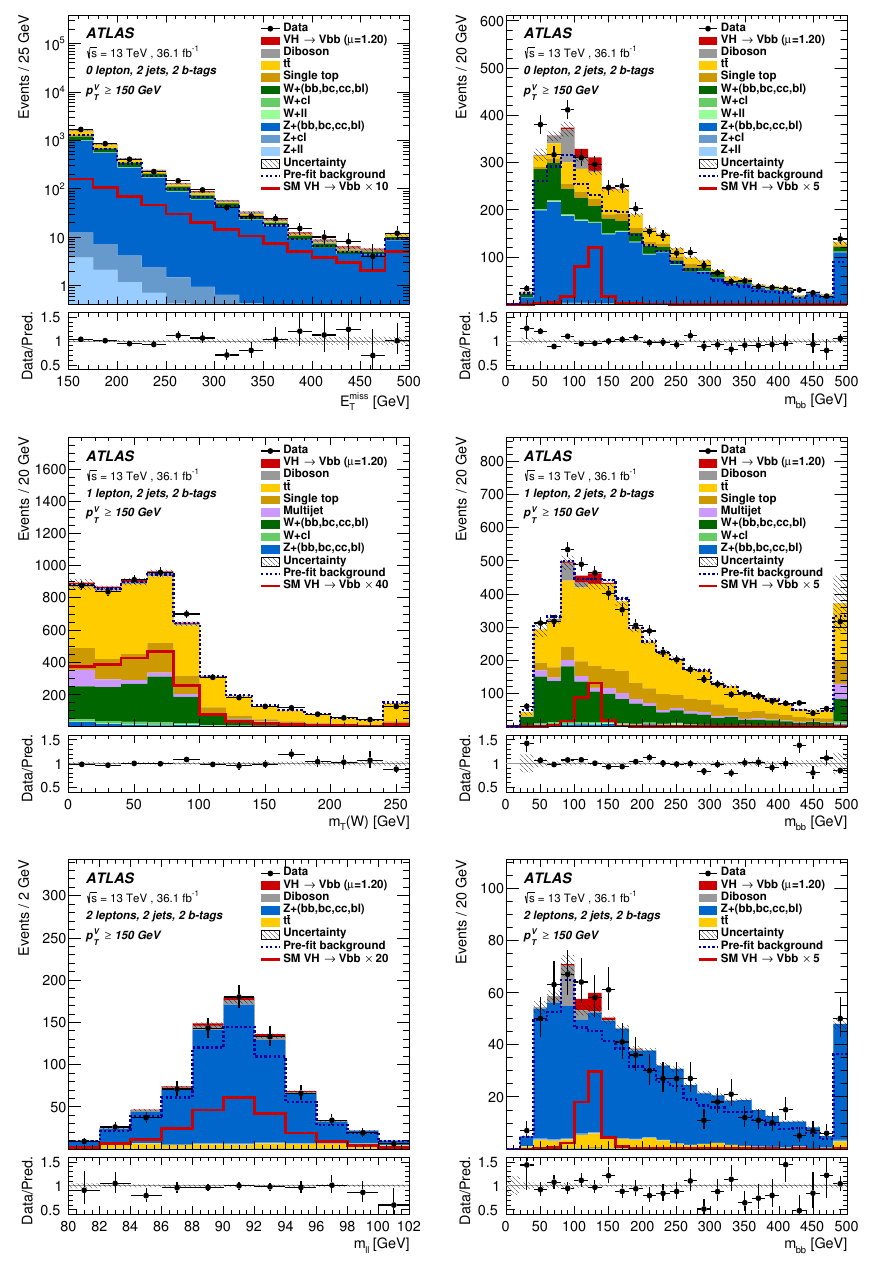
Figure 2 . The post-(cid:12)t distributions for E miss (top left), m W (middle left), m ‘‘ (bottom left) T T and m bb (right) in the 0-lepton (top), 1-lepton (middle) and 2-lepton (bottom) channels for 2-jet, 2- b -tag events in the high p V region. The background contributions after the global likelihood (cid:12)t are T shown as (cid:12)lled histograms. The Higgs boson signal ( m H = 125 GeV) is shown as a (cid:12)lled histogram on top of the (cid:12)tted backgrounds normalised to the signal yield extracted from data ( (cid:22) = 1 : 20), and unstacked as an un(cid:12)lled histogram, scaled by the factor indicated in the legend. The entries in over(cid:13)ow are included in the last bin. The dashed histogram shows the total background as expected from the pre-(cid:12)t MC simulation. The size of the combined statistical and systematic uncertainty for the sum of the (cid:12)tted signal and background is indicated by the hatched band. The ratio of the data to the sum of the (cid:12)tted signal and background is shown in the lower panel.